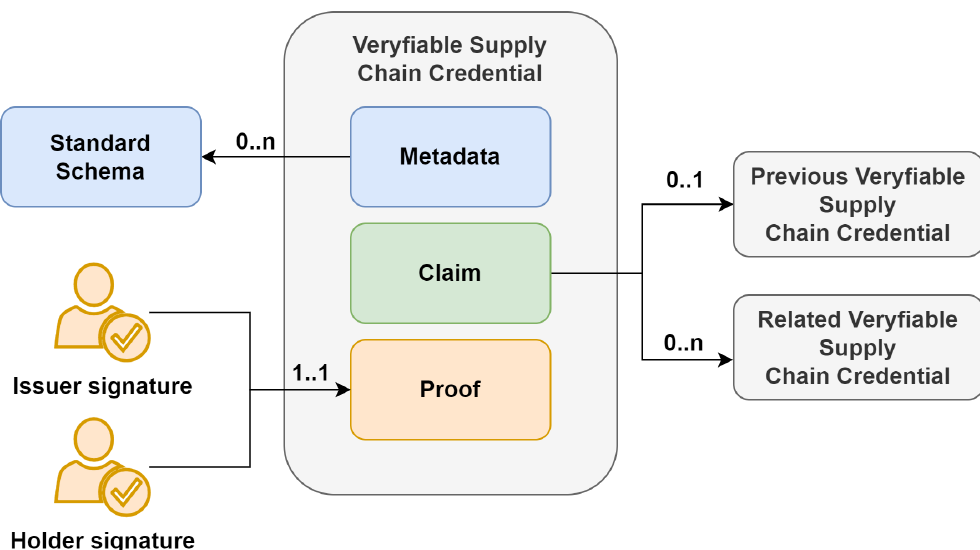
Figure 1. Structure and data model of the Verifiable Supply Chain